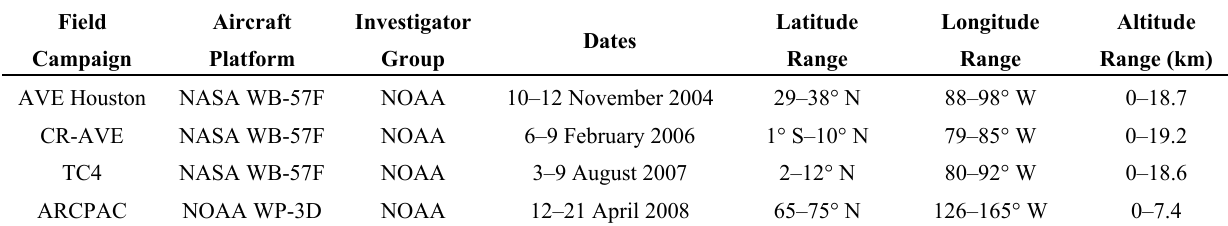
Table 2. Details of BC mass mixing ratio measurements, made with Single Particle Soot Absorption Photometers onboard of NOAA research aircraft